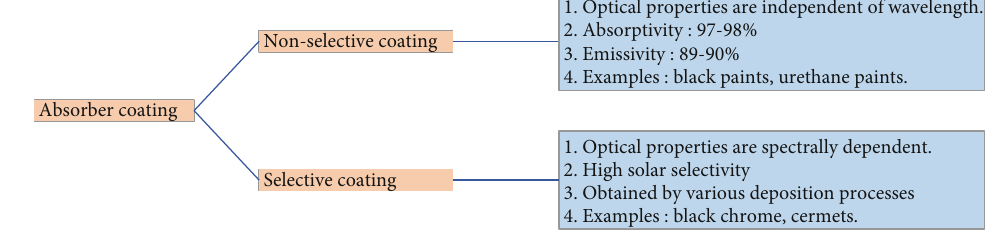
Figure 6: Classi fi cation of solar coatings and their properties